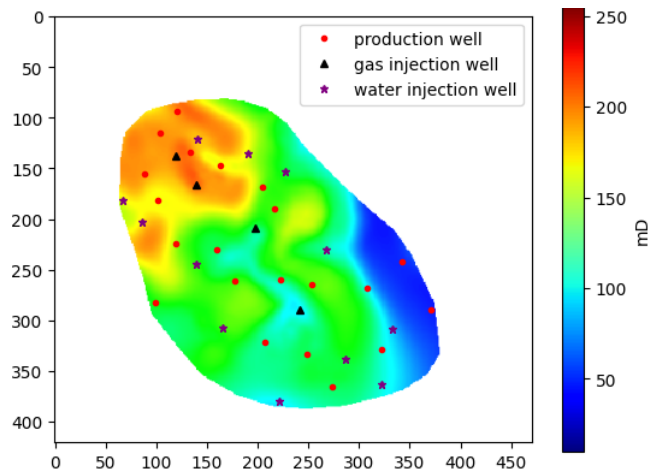
Figure 3. Permeability distribution and well